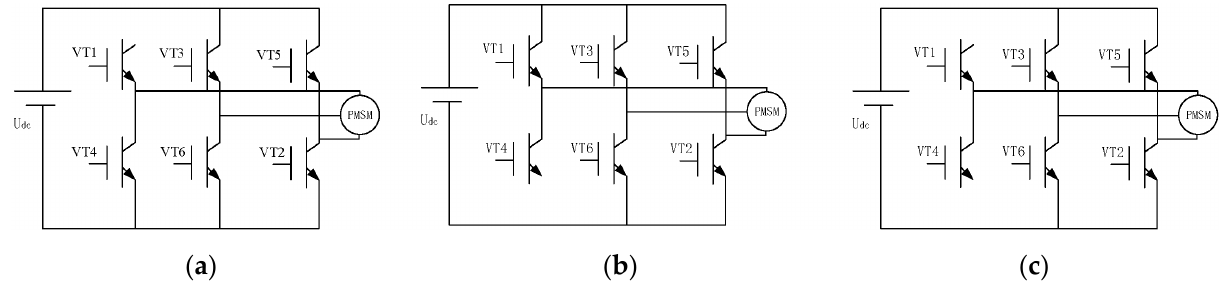
Figure 9. Schematic diagram of A-phase IGBT open circuit. ( a ) Open circuit of upper-bridge IGBT; ( b ) open circuit of lower-bridge IGBT. ( c ) Open circuit of both IGBT.